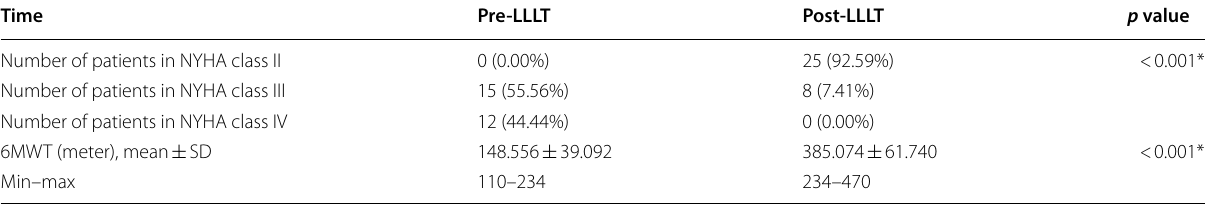
Table 2 Clinical assessments of the study participants